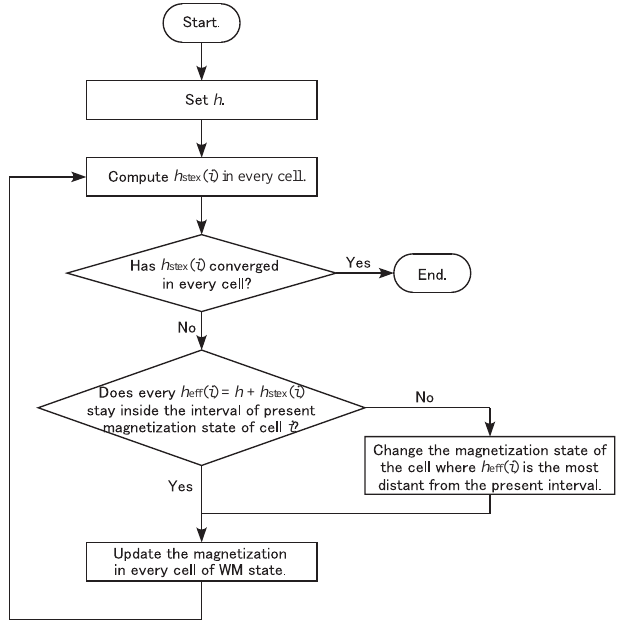
Figure 5: Flowchart of direct solution method.